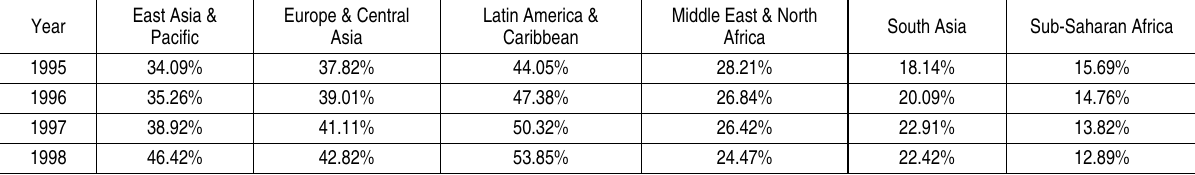
Table 4. Trends in VR external debt as a percentage of total gross external debt